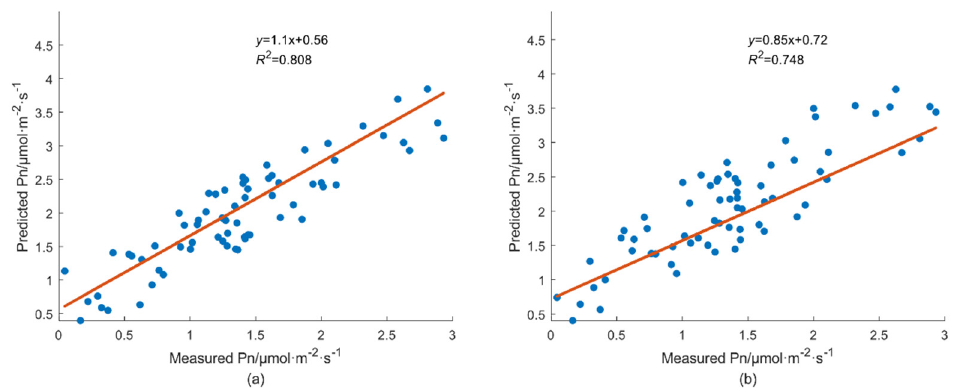
Figure 11. Fitting results: ( a ) MLSTM model result without the CWSI input feature; ( b ) SVR model result without the CWSI input feature.